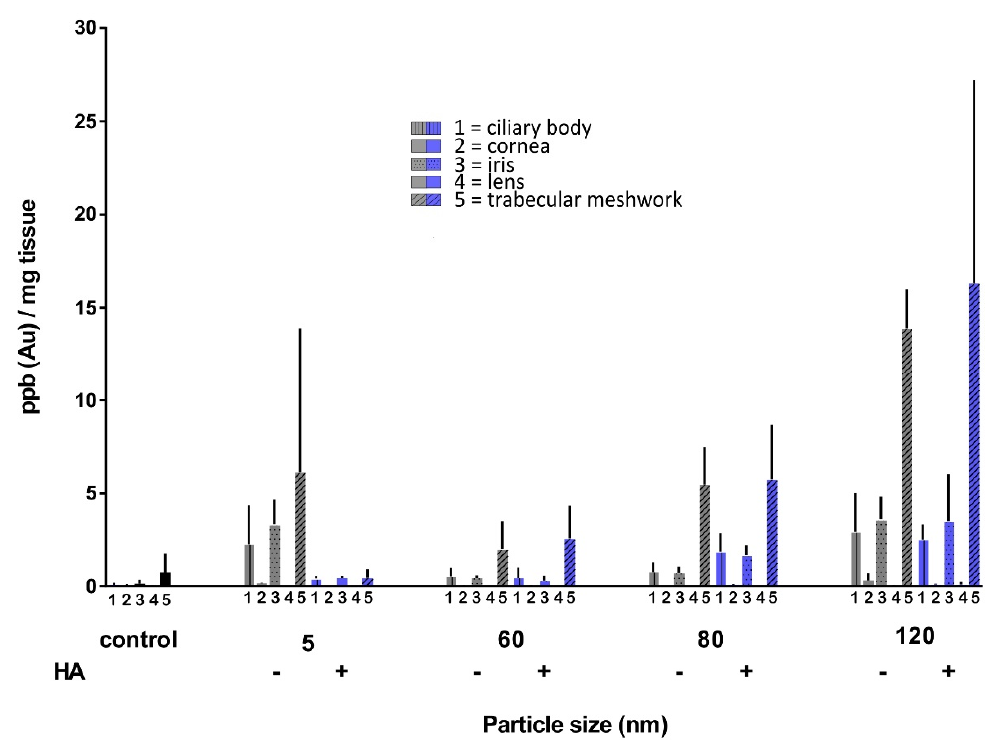
Figure 3. Perfusion of porcine eyes with gold NPs ex vivo. Freshly enucleated porcine eyes were used for ex vivo perfusion. Perfusion was performed with 5, 60, 80 and 120 nm AuNPs (grey bars) and HA-AuNPs (blue bars), respectively. The applied particle concentrations were normalized to a total gold concentration of 9390 ppb. Afterwards, the eyes were dissected into the ciliary body (1), cornea (2), iris (3), lens (4) and trabecular meshwork (5). Each tissue sample was dried, weighed, dissolved in aqua regia and analyzed separately. The amount of gold in parts per billion per mg tissue was analyzed by using ICP-MS. Control experiments (black bars) were conducted with perfusion medium without any gold NPs.